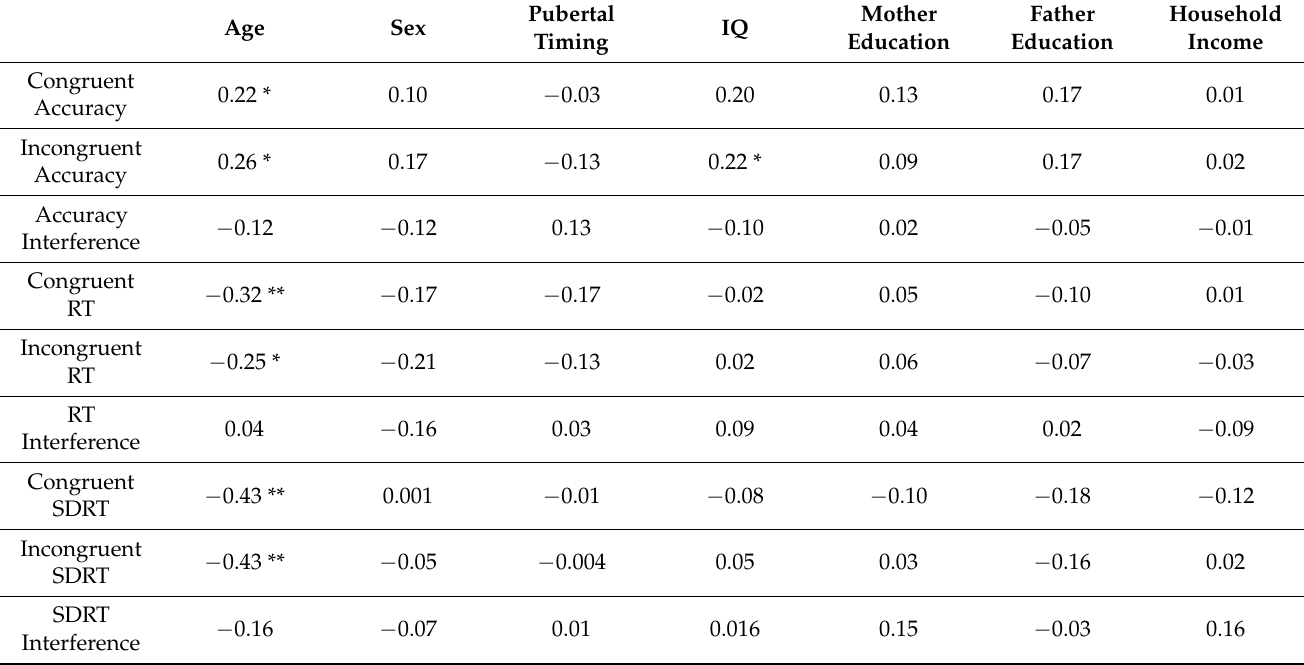
Table 2. Pearson correlations between flanker performance and demographic